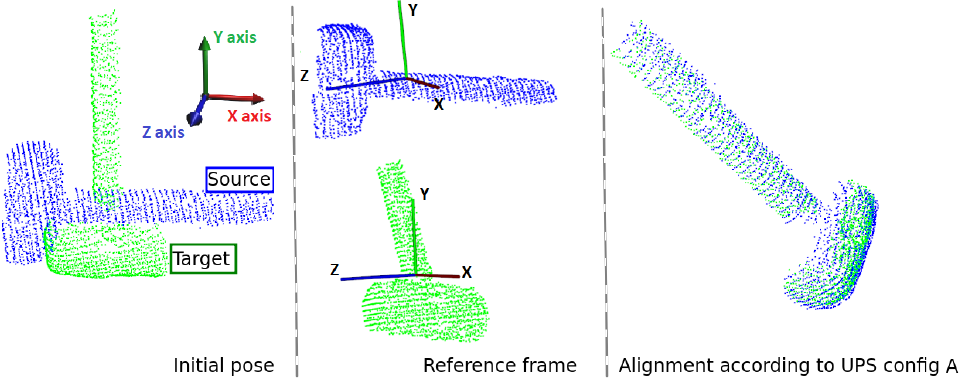
Figure 7. Registration of a cylinder-like object aligned by UPS configuration A.